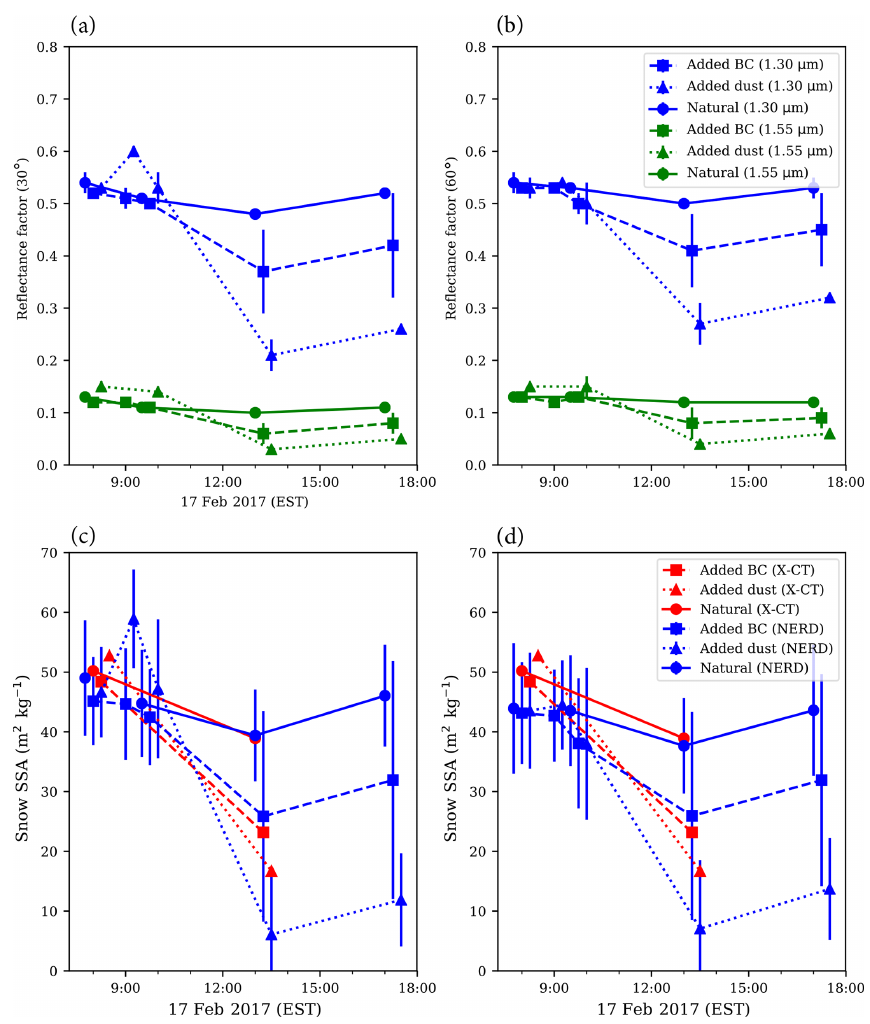
Figure 7. The 17 February experimental results (clear sky). All panels contain NERD measurement data collected from 07:00 through to 17:00EST on 17 February 2017. Filled circles connected by solid lines represent measurements on natural snow. Filled squares connected by dashed lines represent measurements on snow lightly contaminated ( < 1gm − 2 ) by hydrophobic BC. Triangles connected by dotted lines represent measurements on snow contaminated by dust (30gm − 2 ). In panels (a) and (b) , blue (green) curves represent 1.30µm (1.55µm) BRFs at 30 ◦ viewing (a) and 60 ◦ viewing (b) . Error bars represent standard errors calculated from sample averages from as many as eight locations within each 1m 2 plot. In panels (c) and (d) , blue curves represent NERD-calibrated SSAs from 30 ◦ (c) and 60 ◦ (d) viewing BRFs. Red curves represent SSAs derived from X-CT scans. Error bars represent NERD calibration uncertainty computed from regression analysis (standard errors of the